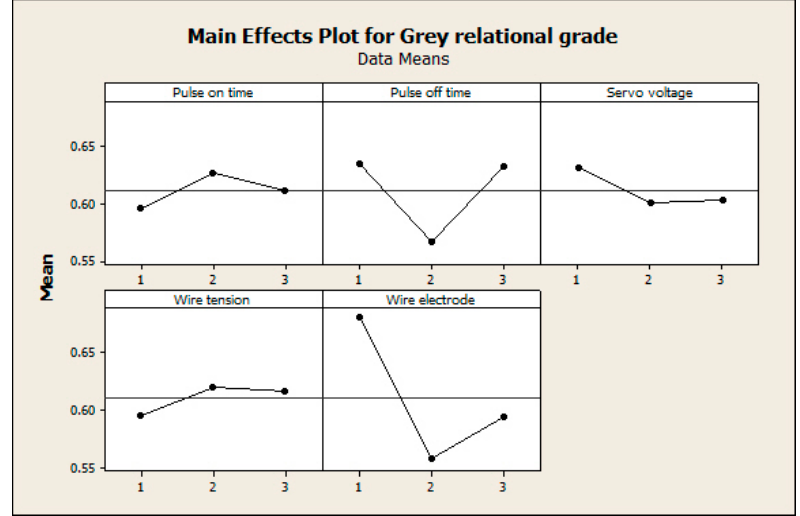
Figure 4. Effects of input process factors on Grey relational grade. Figure 4. E ff ects of input process factors on Grey relational